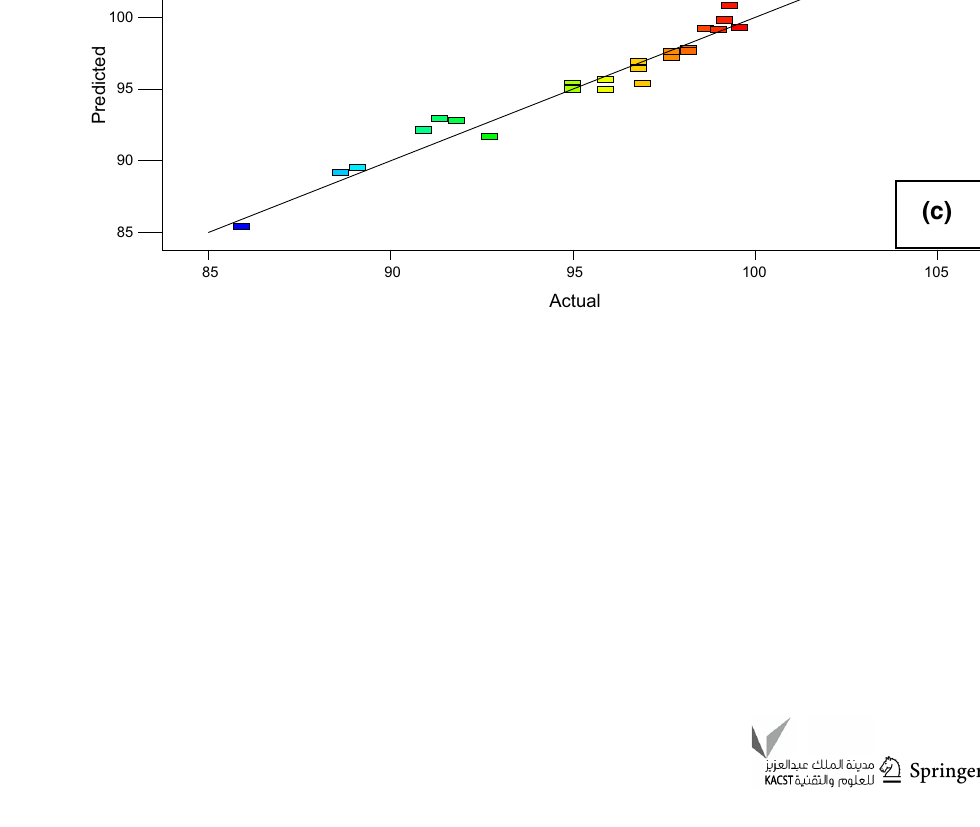
Externally Studentized Residuals